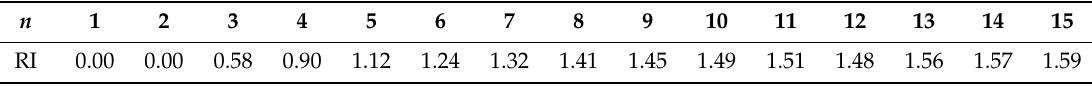
Table 2. Average random consistency indexes random index (RI) of the judgement matrix.